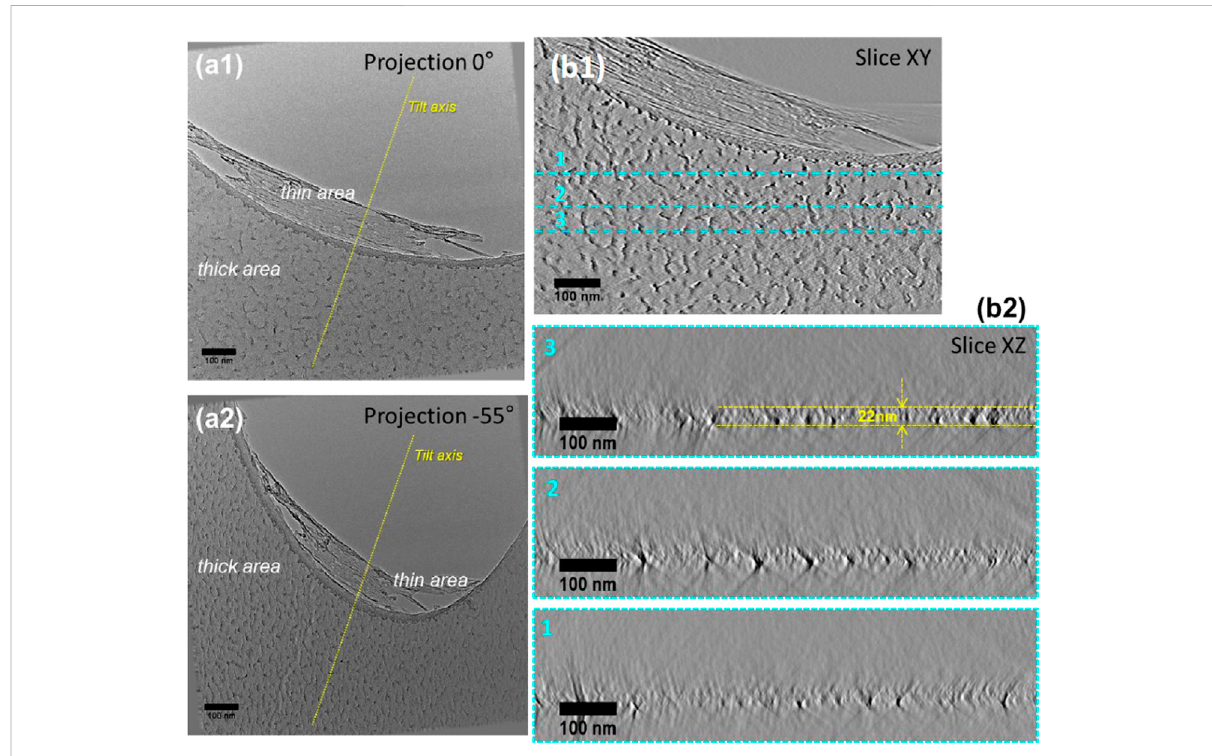
FIGURE 5 Electrontomography analysesofanareaoftheQuantifoil membrane containingathickandthinarea. (A1) and (A2) Projectionsacquiredattwo different tilt angles ( − 55 ° and +0 ° ) from the tilt series used to calculate the reconstruction. (B1) and (B2) . Transversal and longitudinal slices were acquired at different depths and orientations through the reconstructed volume, illustrating the roughness of the Quantifoil